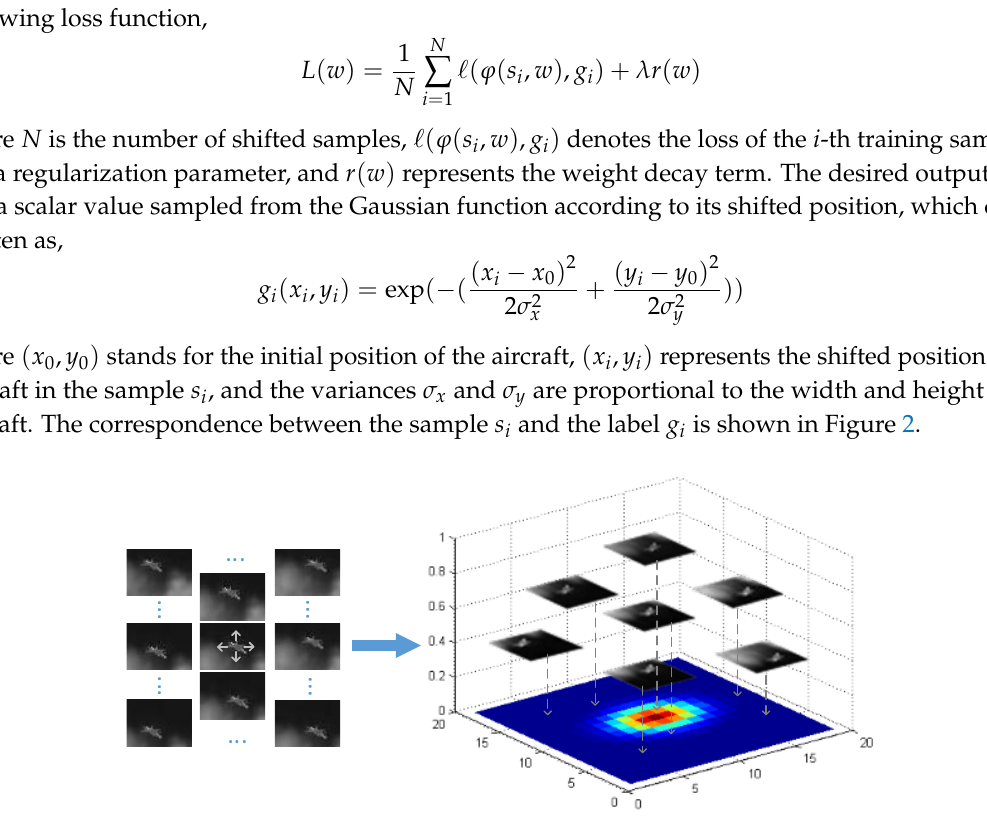
Figure 2. The correspondence between samples and labels. The labels are sampled from the Gaussian